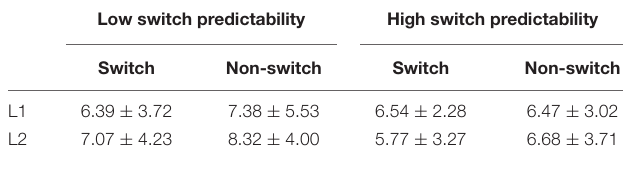
TABLE 5 | Mean amplitudes and standard errors of the early phase elicited by